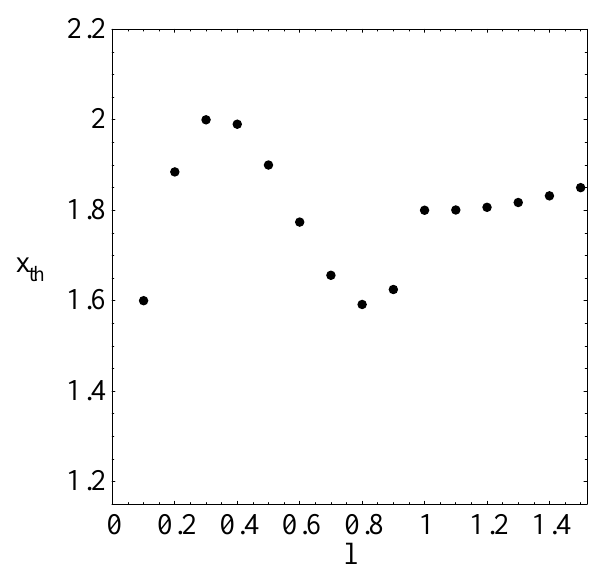
FIG. 9. The flip-flop threshold x th vs l in the model of the bunch